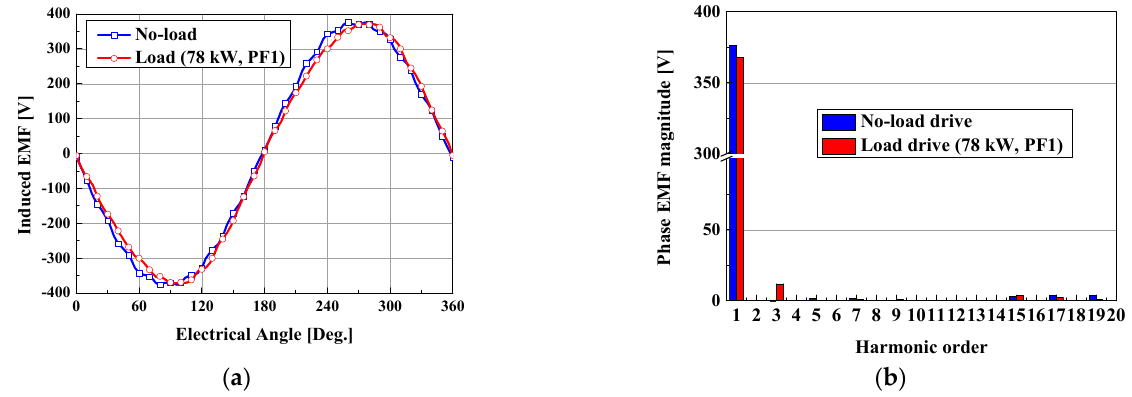
Figure 13. Induced EMF at no-load and load drives for the final design: ( a ) wave form, and ( b ) harmonic order.